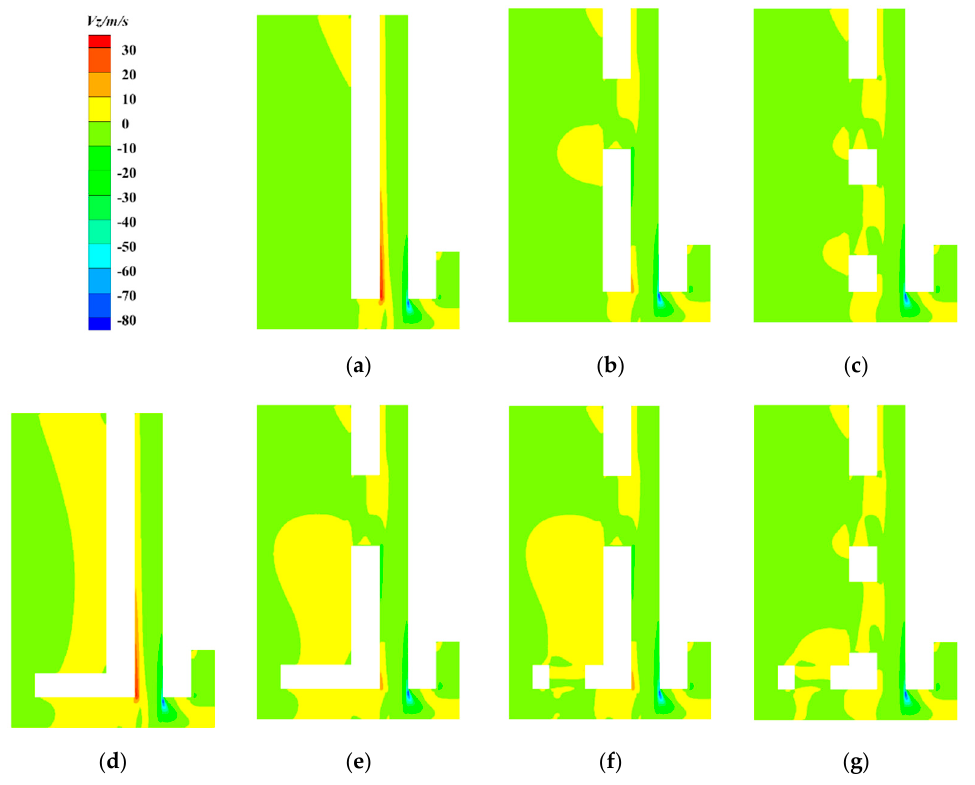
Figure 11. Radial velocity contours: ( a ) Case-1; ( b ) Case-2; ( c ) Case-3; ( d ) Case-4; ( e ) Case-5; ( f ) Case-6; ( g ) Case-7.